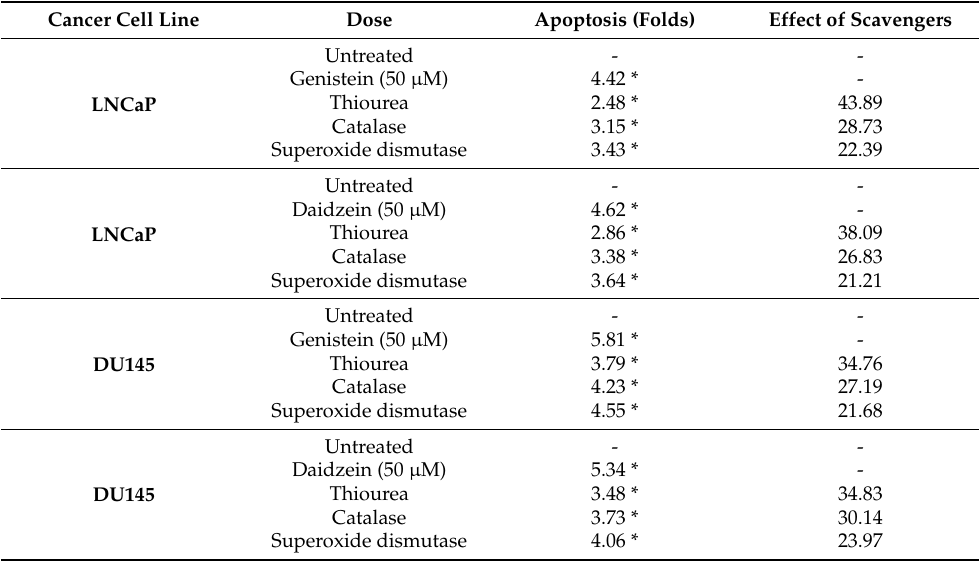
Figure 5. The effect of metal chelators on isoflavone-induced apoptosis in prostate cancer cell lines. LNCaP and DU145 cancer cells were treated with 50 µM genistein/and daidzein alone or in the presence of the copper chelator neocuproine (Neo), iron chelator desferrioxamine mesylate (DM), or zinc chelator histidine (His). The chelators used had a concentration of 50 µM. Apoptosis was detected using the Cell Death Detection ELISA Kit (Roche, Palo Alto, CA, USA). Values reported are mean ± S.E of three independent experiments. * p value < 0.01 when compared to control. Table 1. Effect of ROS scavengers on isoflavone activity in prostate cancer